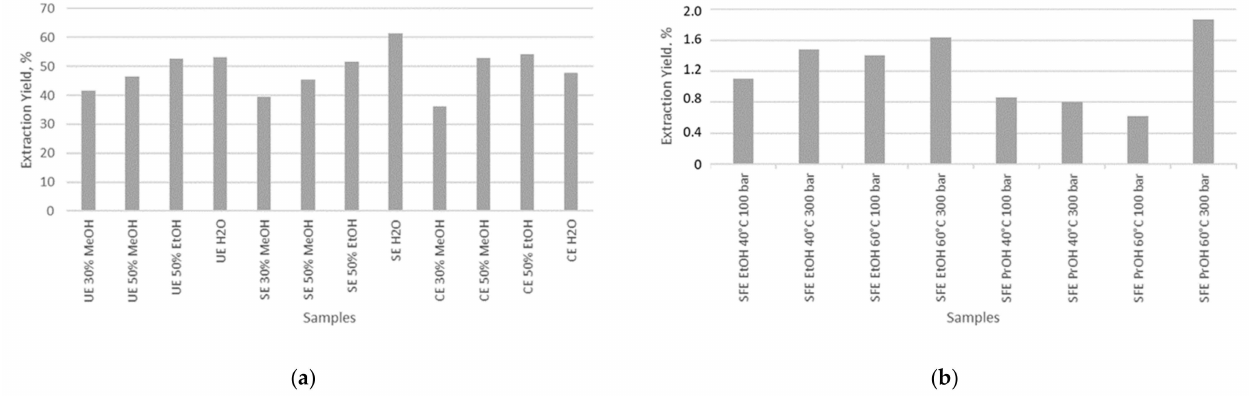
Figure 1. Extraction yield of beetroot extracts obtained by ( a ) ultrasound (UE), Soxhlet (SE), and cold extraction (CE) techniques, and ( b ) supercritical fluid extraction